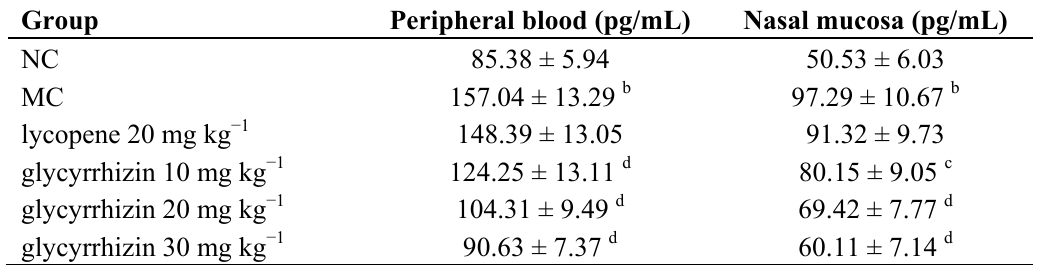
Table 6. Effect of glycyrrhizin treatment on SP level in peripheral blood and nasal mucosa.